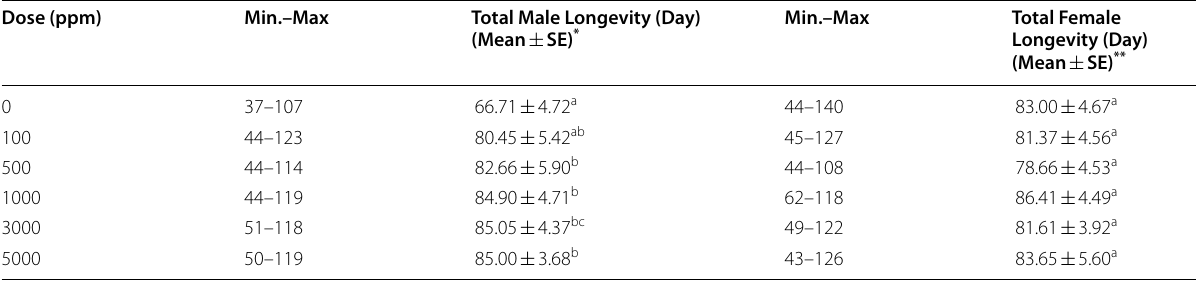
*Mann Whitney U , P <